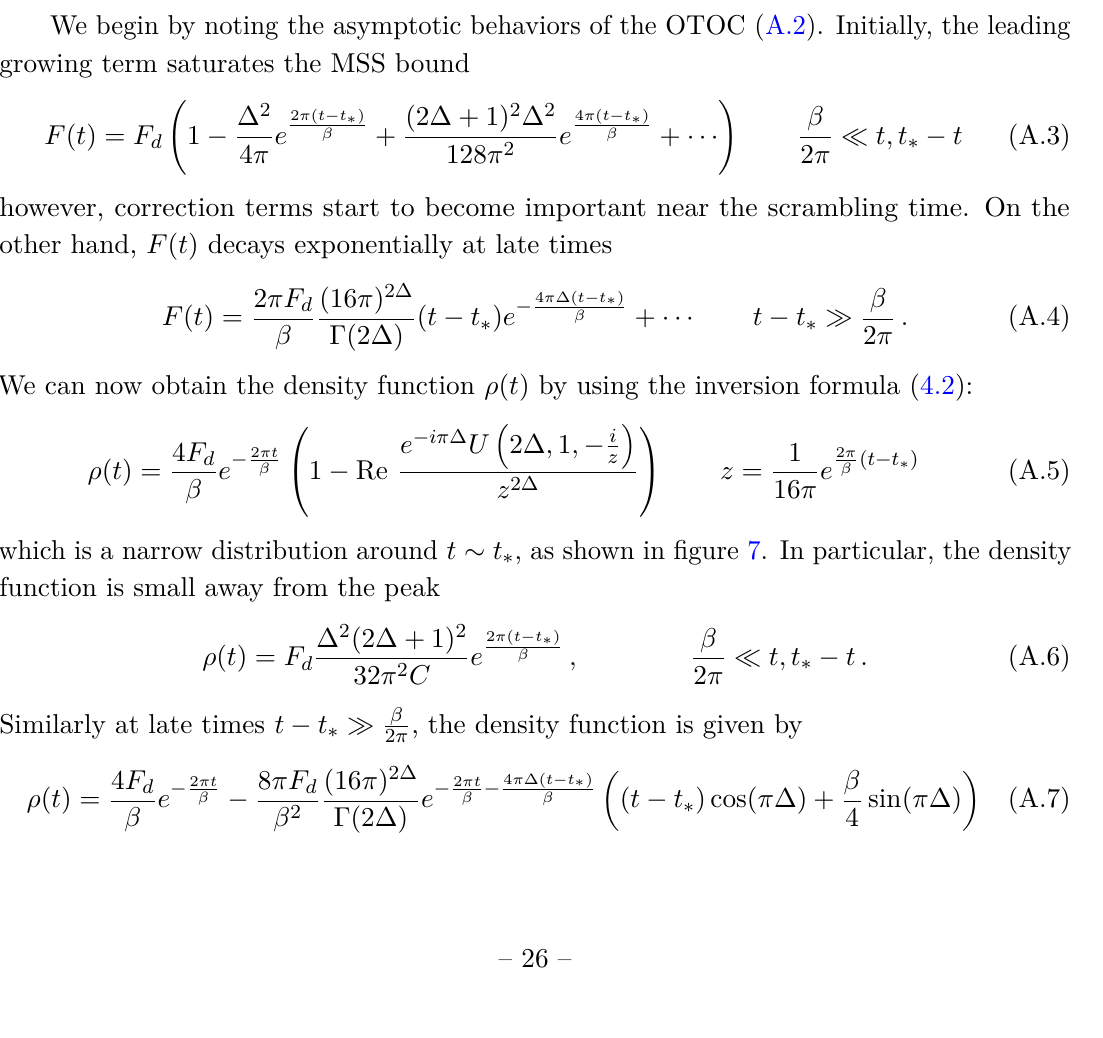
Figure 7 . A generic OTOC and the associated density function (normalized by C ) are shown for the Schwarzian theory. The density function ρ ( t ) has a narrow peak of width ∼ β near the scrambling time t = β ln( C/β ) . So from the perspective of the density function, this is exactly ∗ 2 π a small deformation of extremal chaos where the time scale t is also set by the scrambling time. eff Note that OTOCs of 2d CFTs with a large central charge also have the same qualitative